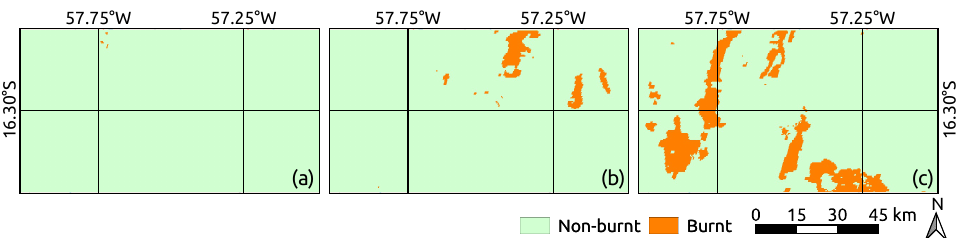
Figure 5. Fire-affected areas according to Modis burn area product for Area 1. The assessment periods regarding epochs I, II, and III are represented by the maps ( a – c ), respectively.